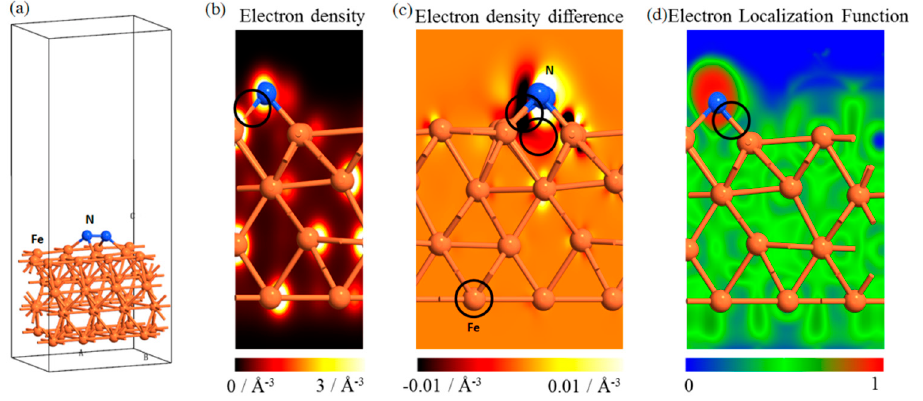
Figure 11. Electronic structure of Fe–N system by first principles: ( a ) model used in the calculation, ( b ) electron density distribution of Fe–N system, ( c ) di ff erential charge density of Fe–N first-principles calculation, ( b ) electron density distribution of Fe–N system, ( c ) differential charge system, ( d ) electron localization function of Fe–N density of Fe–N system, ( d ) electron localization function of Fe–N system.